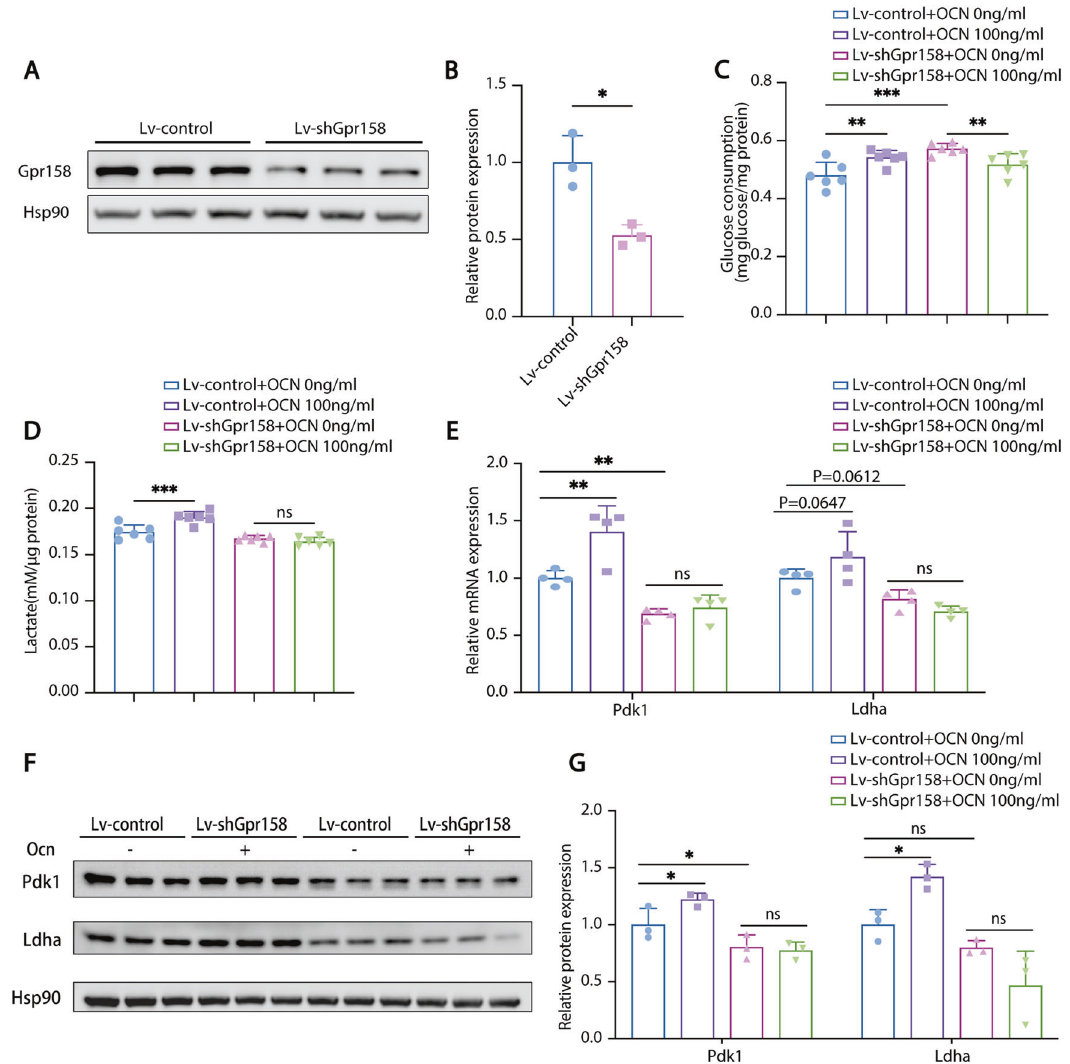
Fig. 7 Ablation of GPR158 blocked the effect of OCN on glycolysis in astrocytes. A , B Protein levels of Gpr158 in control and Gpr158 knockdown C8D1A cells. C Glucose consumption (normalized to total protein) of control and Gpr158 knockdown C8D1A cells treated with vehicle or 100 ng/ml of OCN. D Lactate production (normalized to total protein) of control and Gpr158 knockdown C8D1A cells treated with vehicle or 100 ng/ml of OCN. E qPCR analysis of mRNA levels of glycolytic enzymes of control and Gpr158 knockdown C8D1A cells treated with vehicle or 100 ng/ml of OCN. F , G Protein levels of glycolytic enzymes of control and Gpr158 knockdown C8D1A cells treated with vehicle or 100 ng/ml of OCN. (Data are presented as mean ±